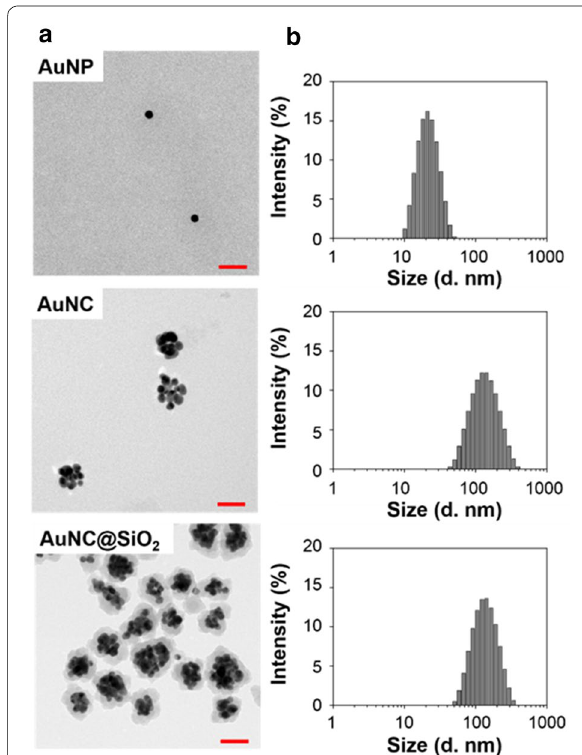
Fig. 1 Size and shape confirmation of each Au nanoparticle. a TEM images of AuNP, AuNC and AuNC@SiO 2 . The size of scale bars is 50 nm. b Particle size distribution histograms of AuNP, AuNC, and AuNC@SiO 2 , from the upper to lower right. Each DLS data point is an average of 15